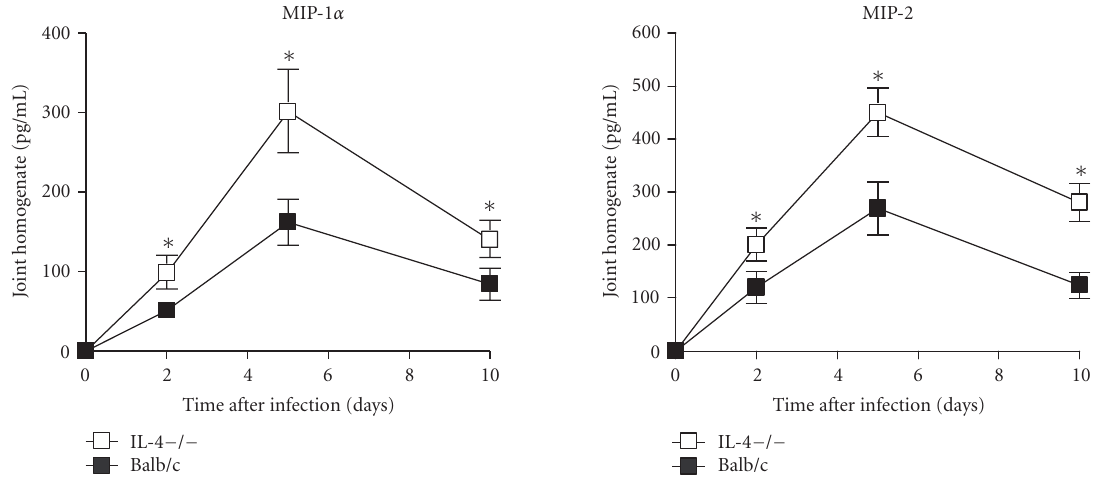
Figure 5: Chemokine production in joints . IL-4-deficient or wt mice infected with 1 × 10 7 GBS/mouse. Supernatants from joint homogenates were collected at the indicated times after infection and assayed for Mip-1 α and MIP-2 by ELISA as detailed in materials and methods (see Section 2). Values are the mean ± SD of three separate experiments each consisting of 20 mice per experimental group. Three mice per group were sacrificed at each time point. Statistical di ff erences between the experimental groups were marked with asterisk ( P < .